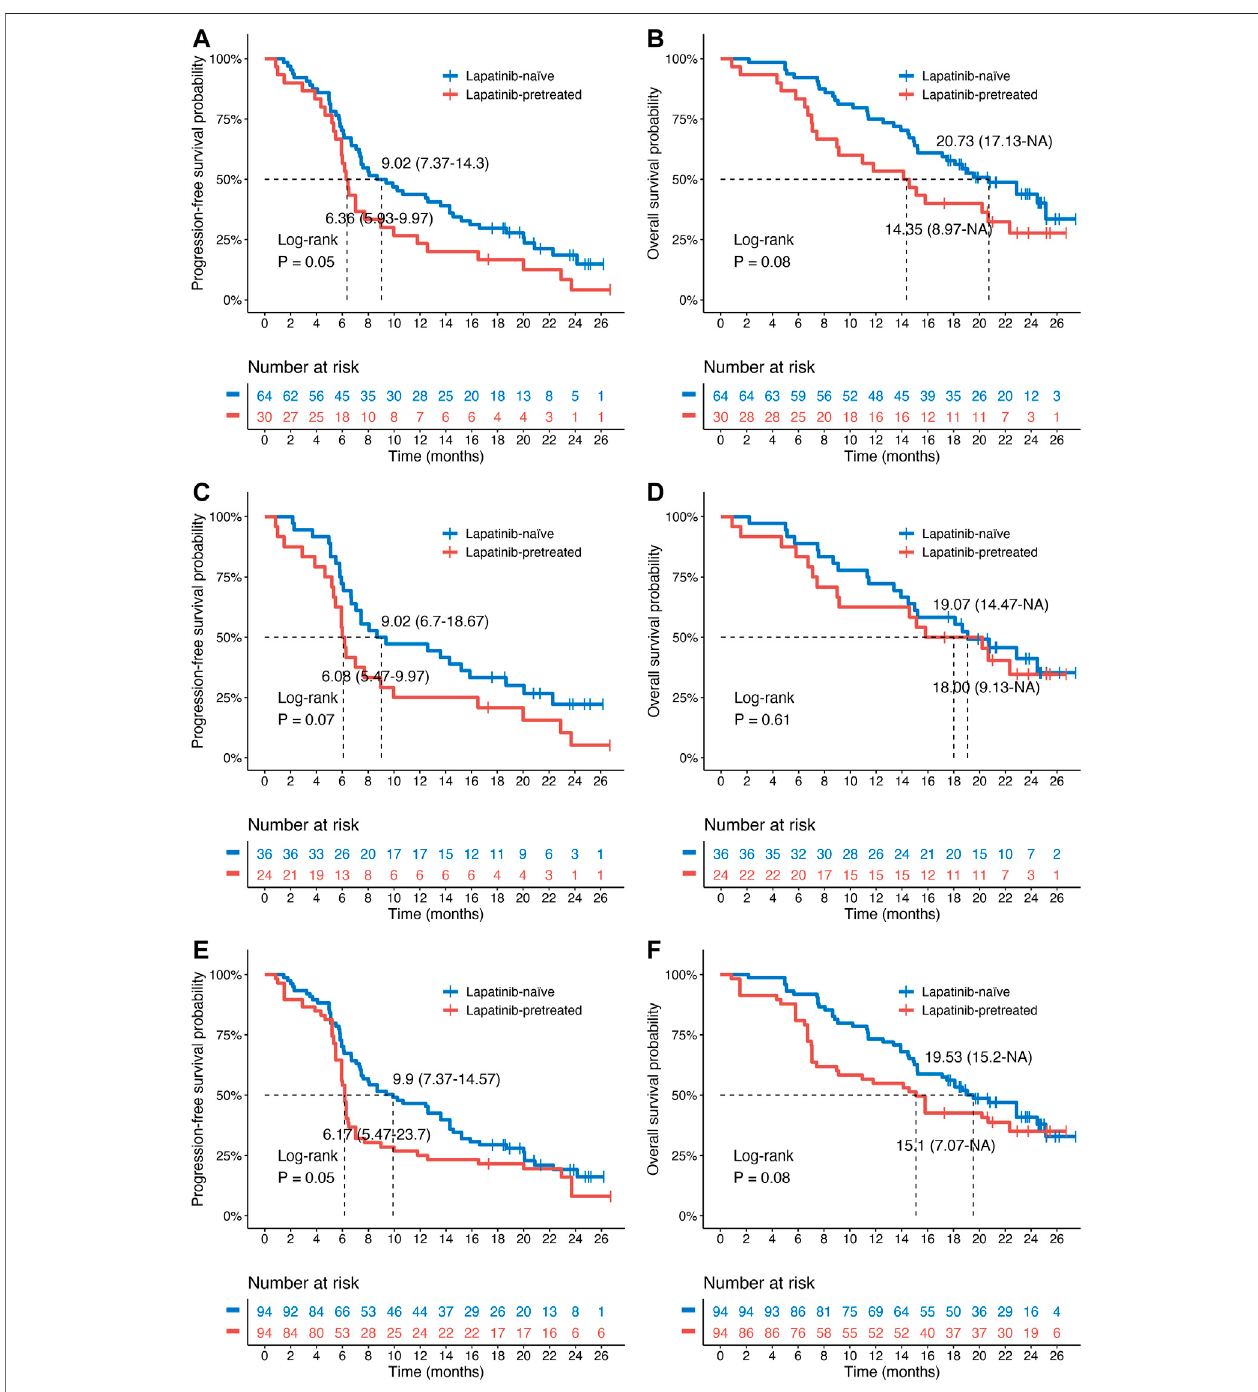
FIGURE 2 | Kaplan – Meier survival curves for patients with HER2-positive MBC treated with pyrotinib as a third- or higher-line treatment. (A,B) Progression-free survival (PFS)/overall survival (OS) of lapatinib-naive ( n (cid:1) 64) and lapatinib-treated ( n (cid:1) 30) patients in the original cohort. (C,D) PFS/OS of lapatinib-naive ( n (cid:1) 36) and lapatinib-treated ( n (cid:1) 24) patients in the PSM cohort. (E,F) PFS/OS of lapatinib-naive ( n (cid:1) 94) and lapatinib-treated ( n (cid:1) 94) patients in the IPTW-adjusted cohort. The p -values were determined by univariate log-rank tests. PSM, propensity score matching; IPTW, inverse probability of treatment weighting.